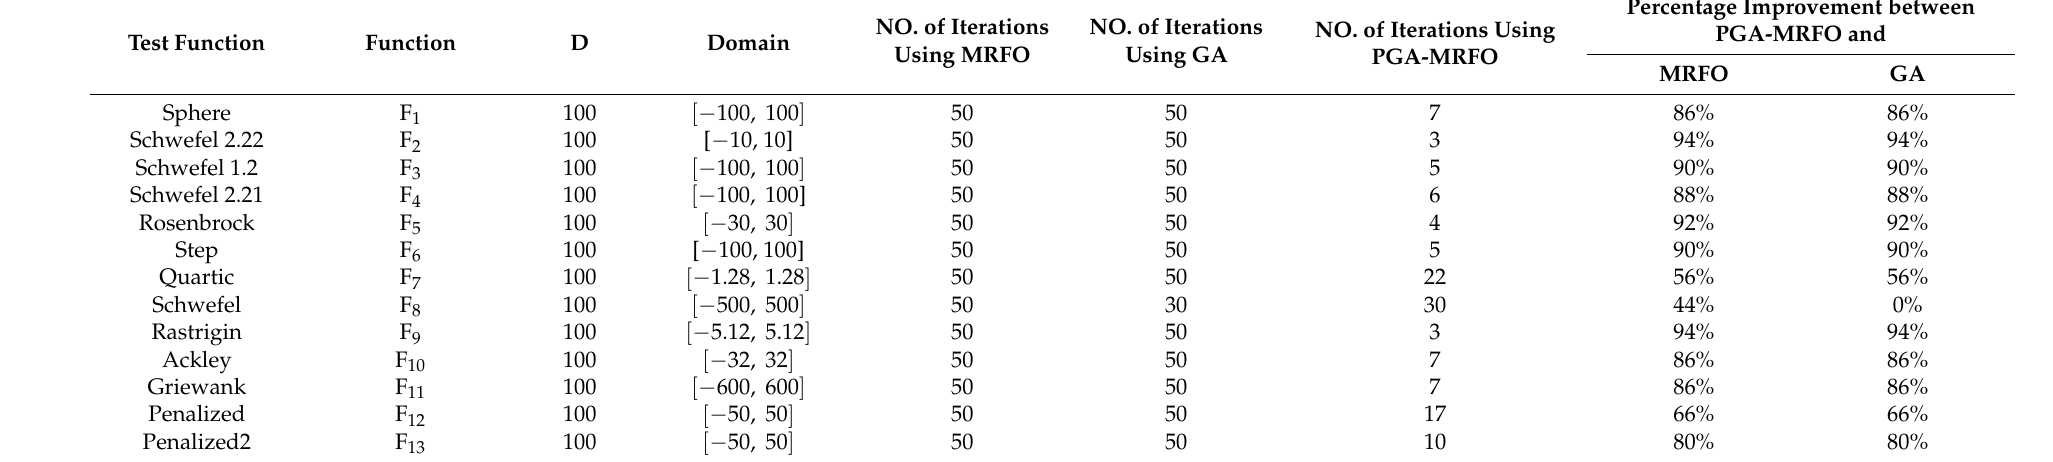
Table 2. Comparison between the three algorithms according to consumed